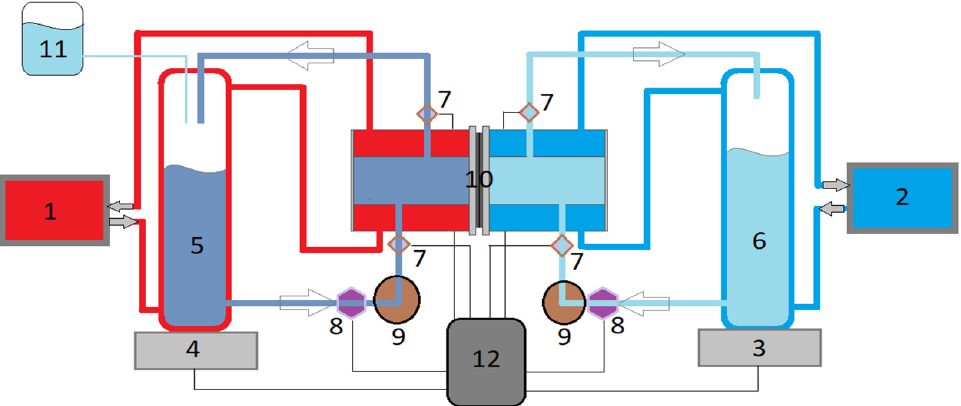
Figure 4. Schema of the long-term DCMD experimental system: 1. thermostat connected to the feed container; 2. cryostat connected to the permeate container; 3. precision balance; 4. precision balance; 5. feed container; 6. permeate container; 7. temperature sensors; 8. flow rate sensors; 9. double head peristatic pump; 10. membrane module; 11. reservoir; 12. com- puter.